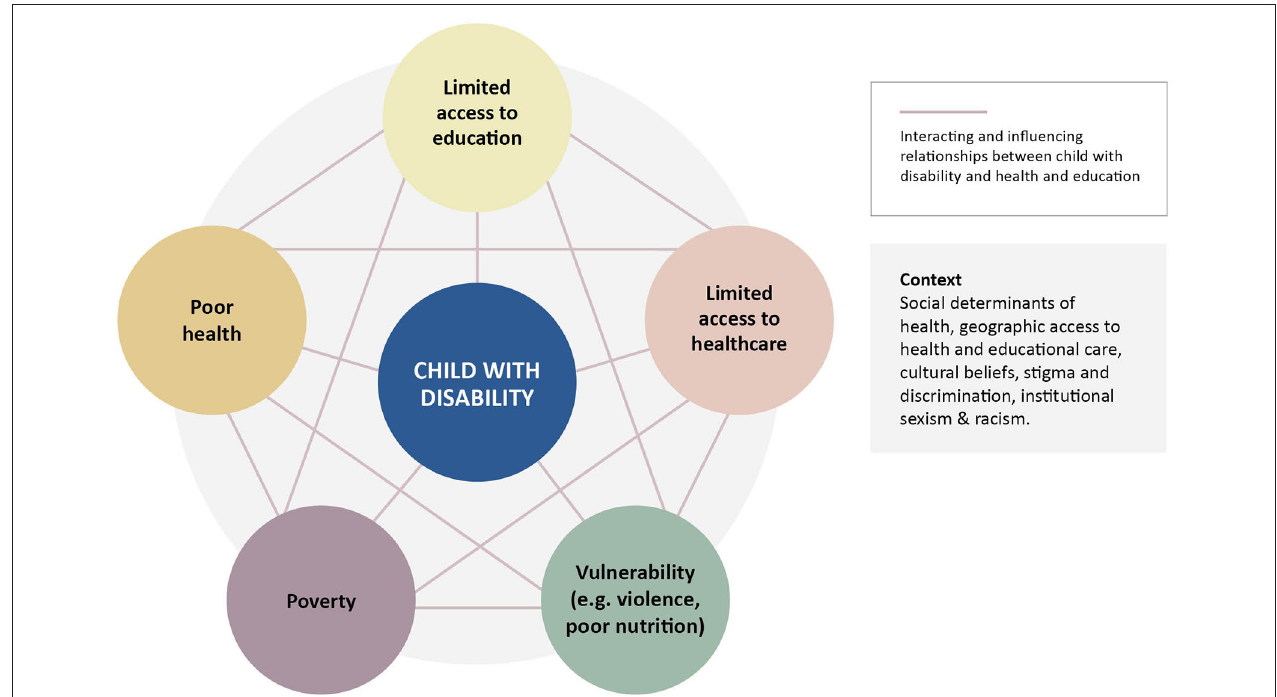
FIGURE 1 | Interrelationship between disability, poor health and limited access to